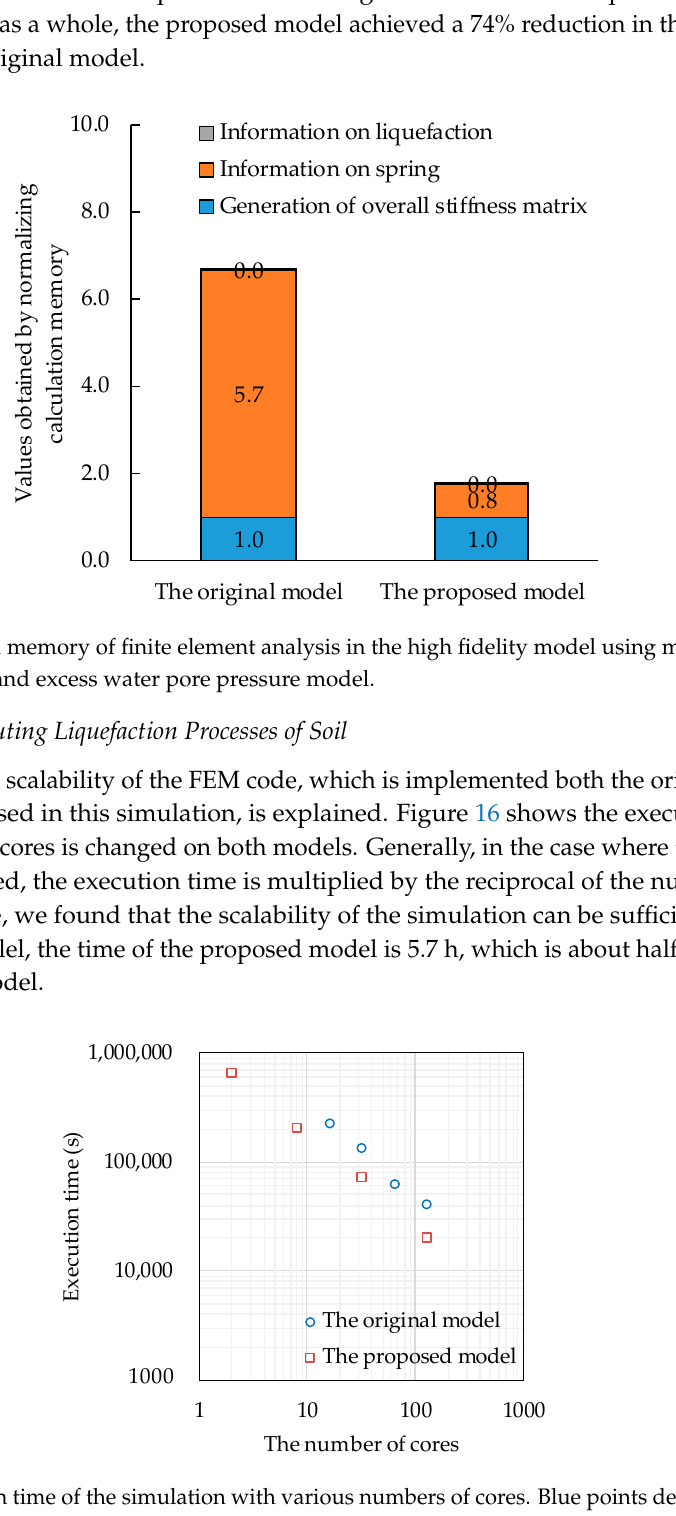
Figure 14. The excess pore water pressure ratio distribution at 15.36 s in ( a ) the original model and ( b ) the proposed model.